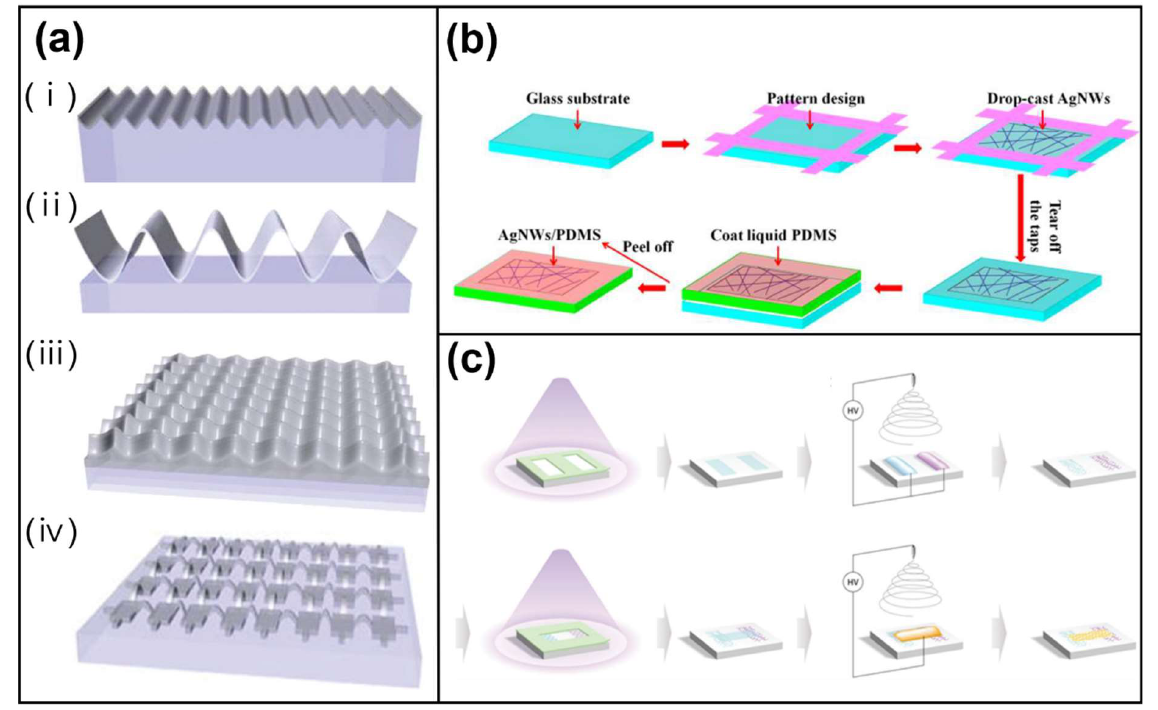
Figure 10. Schematic illustrations of fabrication processes. ( a ) Wavy structures of stretchable inorganic materials. ( i ) One- dimensional wavy inorganic ribbon (grey) bonded to an elastomeric substrate (blue). ( ii ) One-dimensional buckled inorganic ribbon bonded to an elastomeric substrate only at the positions of the troughs. ( iii ) Two-dimensional wavy membrane, as an extension of the concept in ( i ). ( iv ) Two-dimensional buckled mesh, as an extension of the concept in ( ii ). Only rectangular islands are bonded to the elastomer. Copyright © 2021 Wiley-VCH Verlag GmbH & Co. KGaA, Weinheim. ( b ) Manufacturing of AgNW/PDMS transparent electrode using percolation networks. Copyright and licensing: The Royal Society of Chemistry has an exclusive publication license for this journal. ( c ) Electrospinning using a functional electrolyte as a collecting electrode. © 2021 Wiley-VCH Verlag GmbH & Co. KGaA, Weinheim.